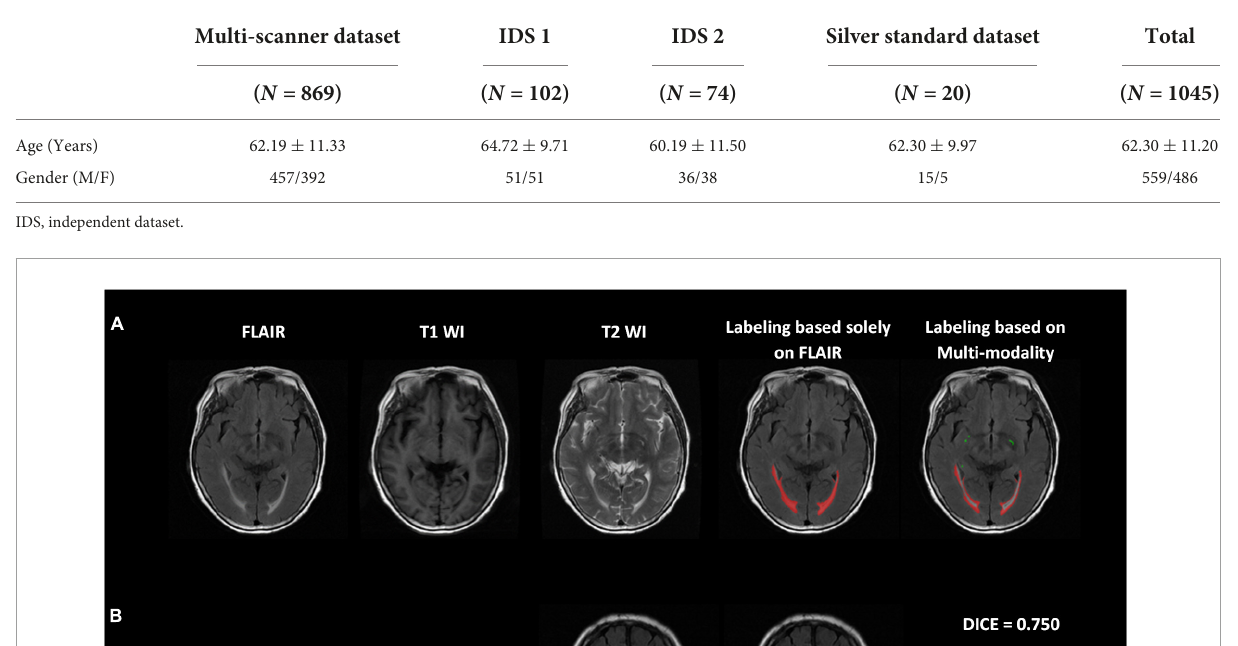
0.955 to 0.992 ( P < 0.01). We have released a portion of delineation data at